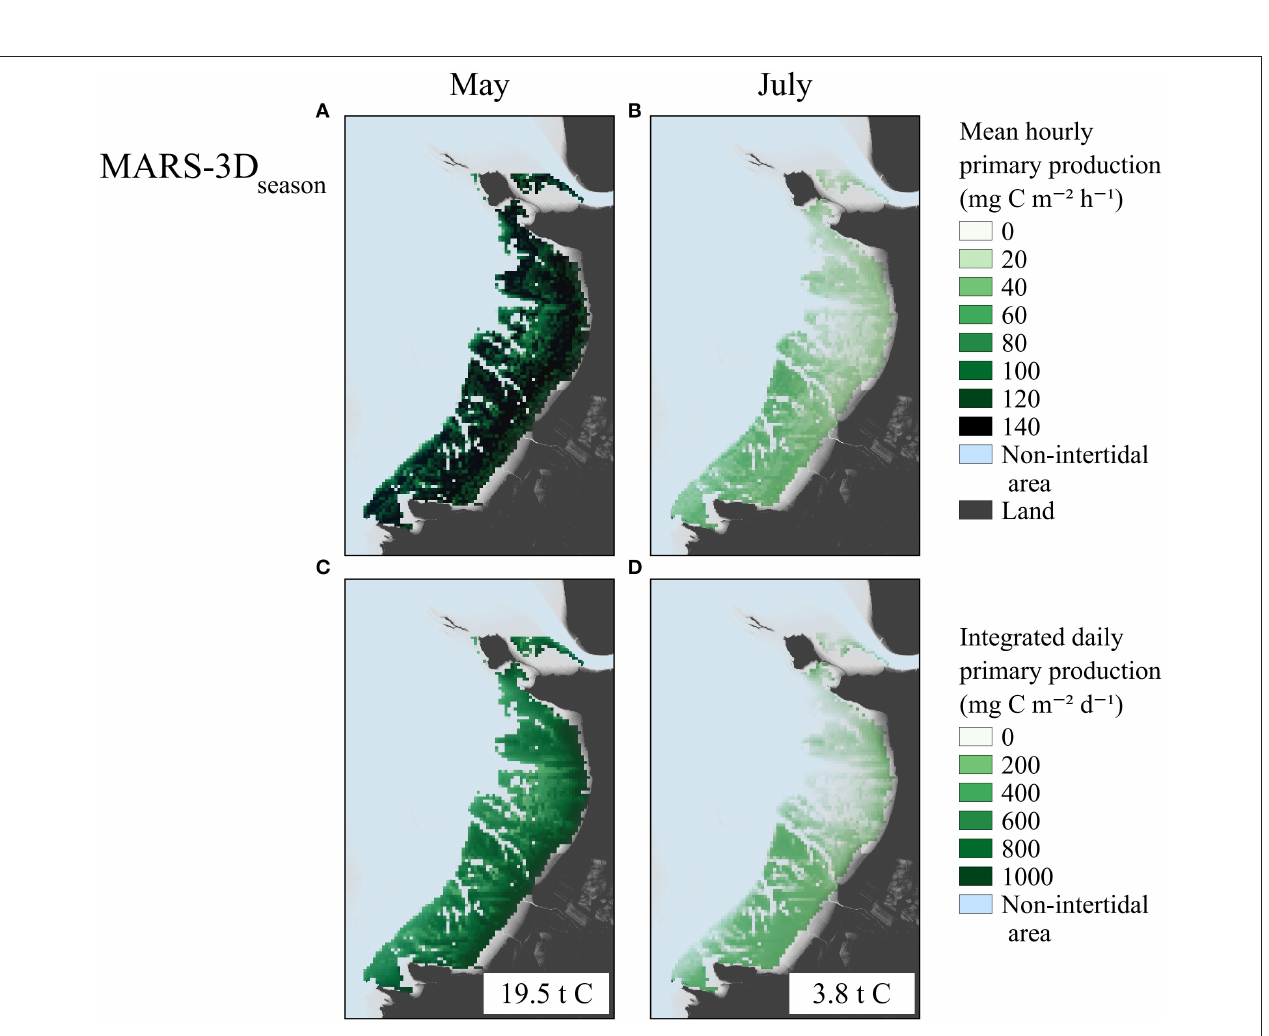
FIGURE 6 | Mean hourly (mg C m − 2 h − 1 ) and daily integrated (mg C m − 2 d − 1 ) GPP simulated in the MARS-3D season run on satellite acquisition matching days in May (A,C) and July 2015 (B,D) . Values indicated in white frames in (C,D) correspond to the GPP spatially integrated over the mudflat in t C.